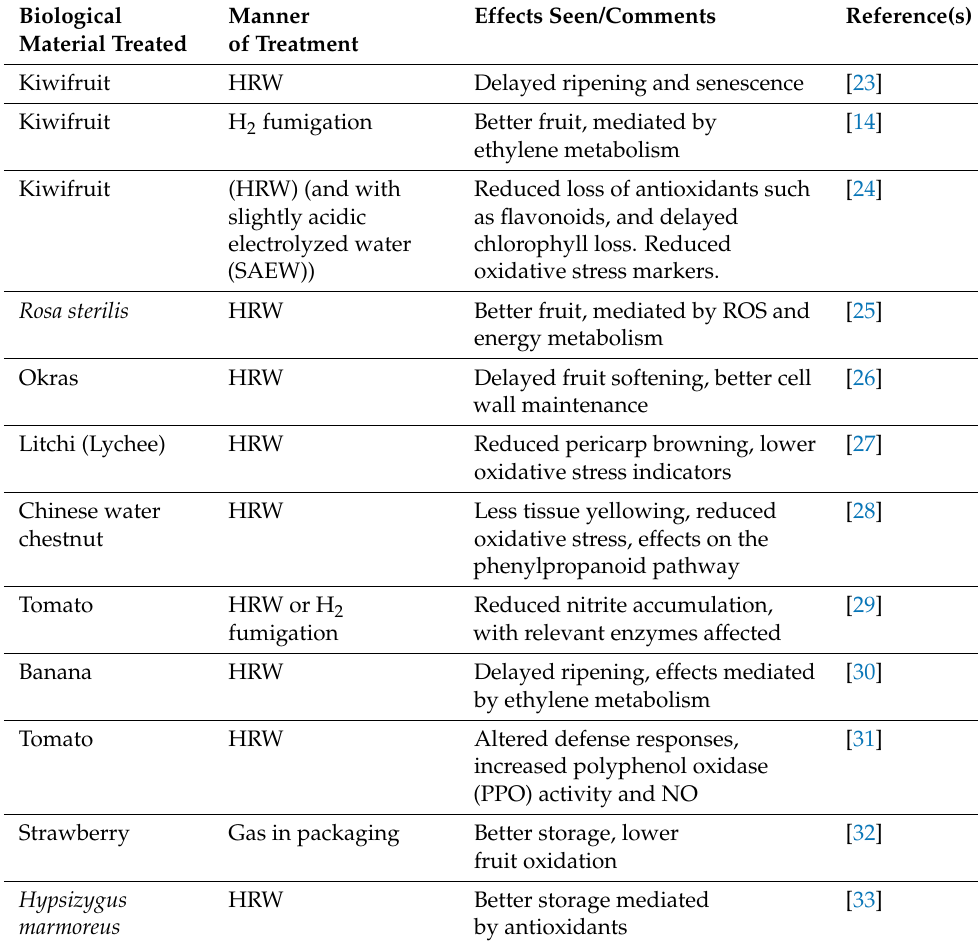
Table 1. Some of the examples of molecular hydrogen treatment of postharvest fruit and